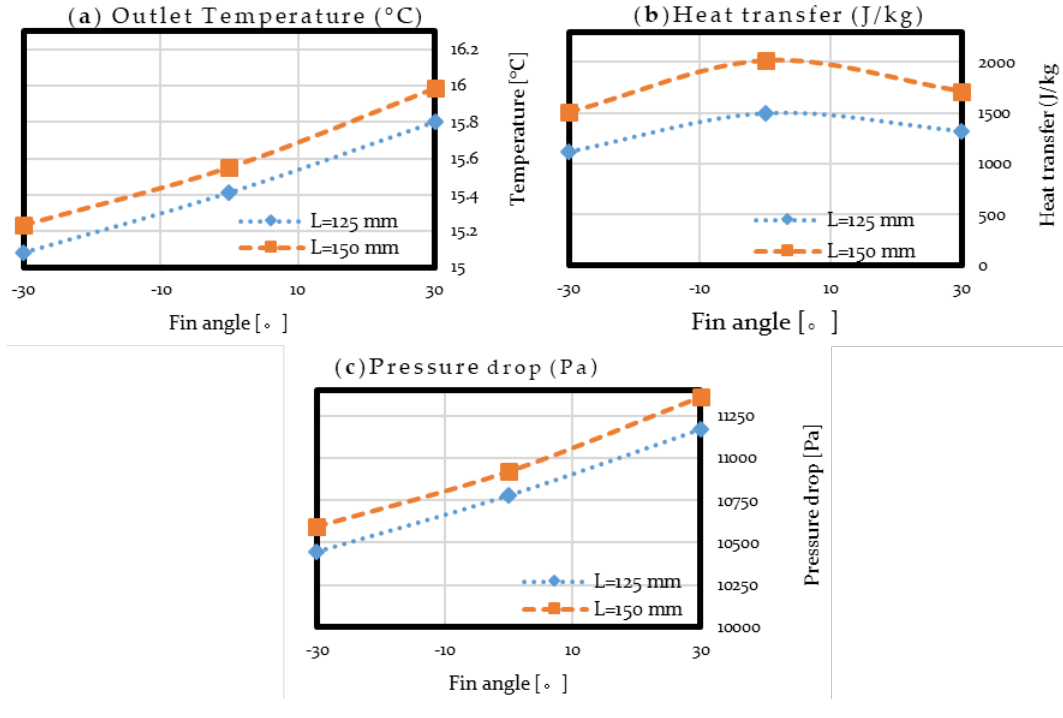
Figure 8. E ff ect of ba ffl e slope and slope on ( a ) Outlet temperature; ( b ) Heat transfer and Figure 8. Effect of baffle slope and slope on ( a ) Outlet temperature; ( b ) Heat transfer and ( c ) Pressure drop. ( c ) Pressure drop. Figure 7. Streamlines of PVT depending on Baffle length